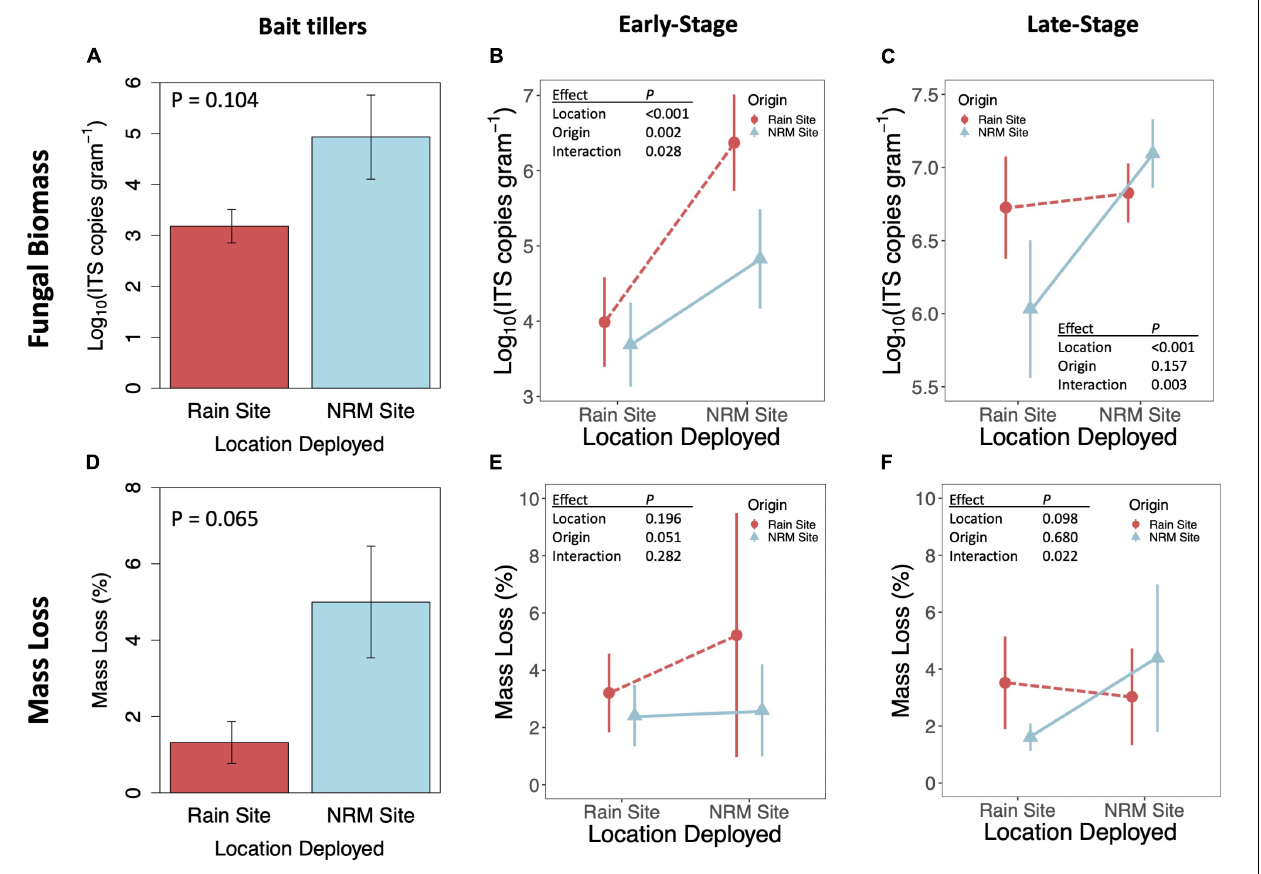
FIGURE 5 | Fungal biomass as indicated by Log 10 ITS copies gram - 1 (top row) and mass loss after one year (bottom row) for bait tillers (A,D) , early-stage tillers (B,E) , and late-stage tillers (C,F) . P-values are for t-tests for bait tillers and two-way ANOVAs for early- and late-stage tillers; full ANOVA results are reported in Supplementary Table 3 . Fungal biomass statistics were run on log10 transformed data. Error bars show 95% CI. Sample sizes are included in Supplementary Table 1